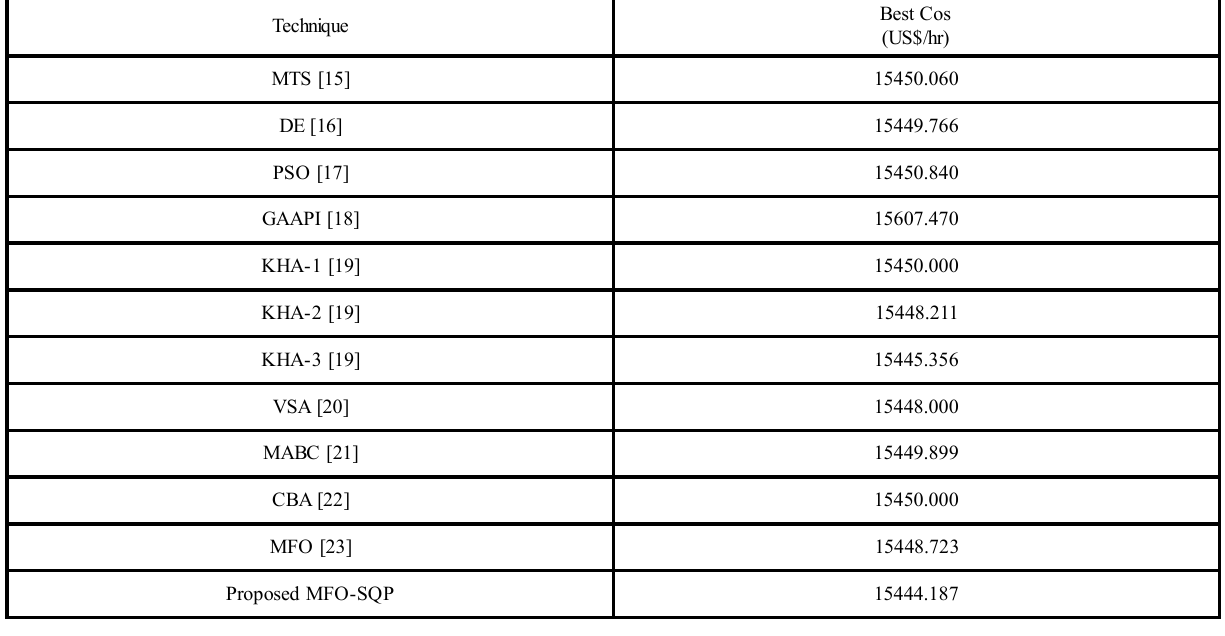
TABLE2. COMPARISON OF 6 UNITS TEST